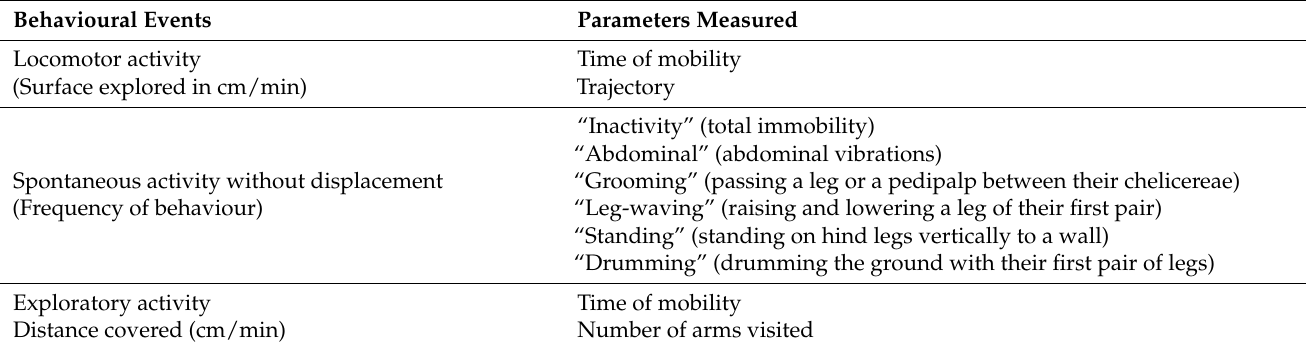
Table 1. Parameters measured for evaluation of locomotor, exploratory and spontaneous activities of a spider in its terrarium and during behavioural tests in a novel environment (open-field arena and radial-arm